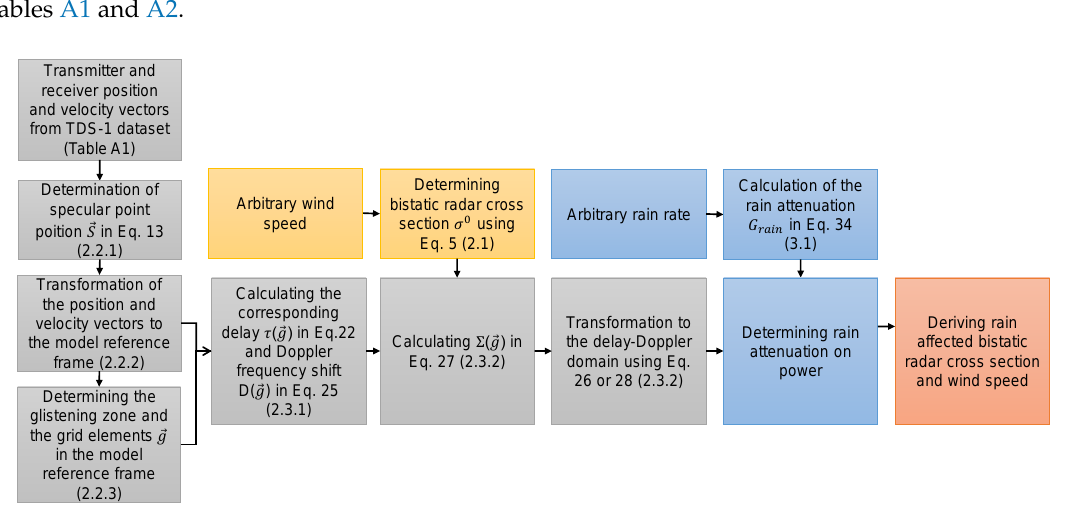
Figure 5. An overview of the simulation procedure of DDMs and calculation of rain attenuation effects in this